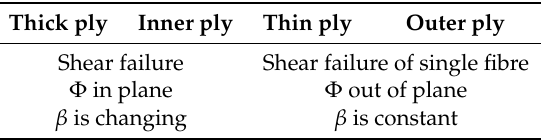
Table 4. Observations on damage type and kink-band geometry in dependency of ply thickness and ply position within the